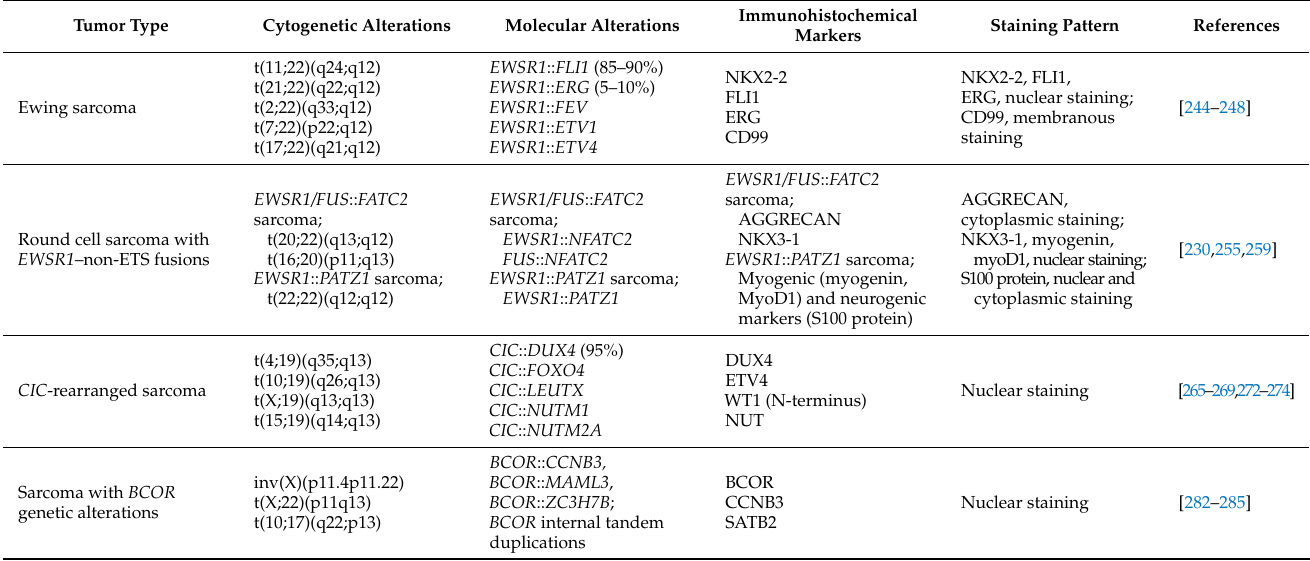
Table 2. Molecular genetic alterations and immunohistochemical markers in undifferentiated small round cell